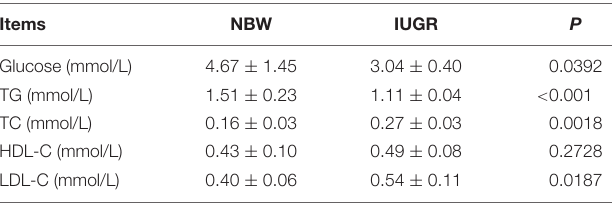
TABLE 3 | Concentrations of lipid metabolites in plasma between NBW and IUGR neonatal piglets.